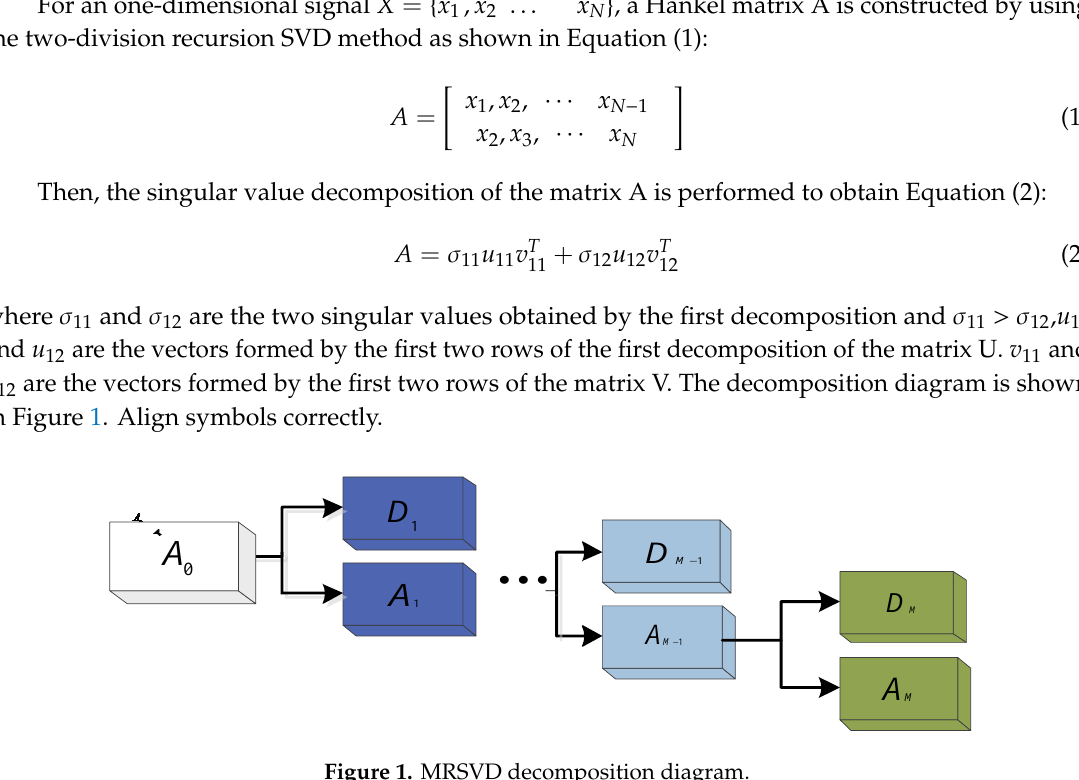
Figure 1. MRSVD decomposition diagram.